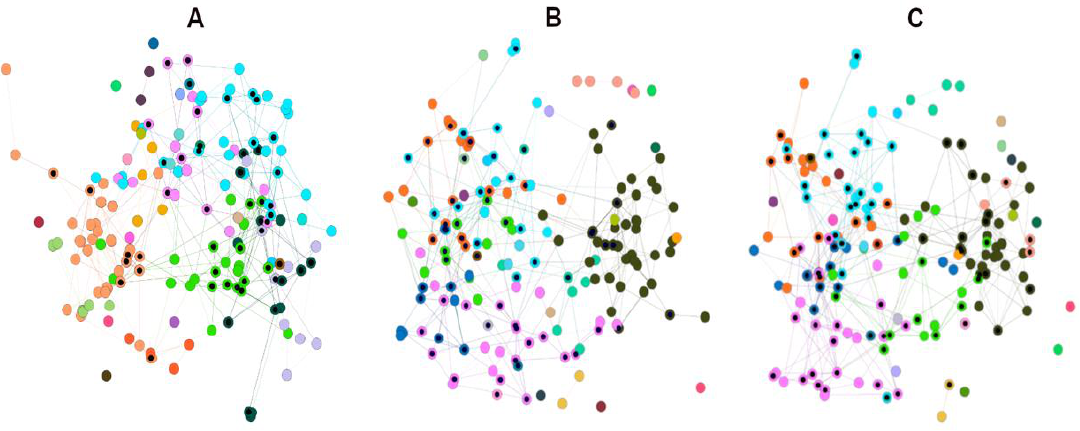
Figure 6. Overlapping subsets 6, 7 and 8 resulting from the union of the harmonic and hub-bridge centralities at 0.35, 0.40 and 0.45 over the HSPN model. ( A ) 52 ABFPs from the HC ∪ HB of the subset 8 (cutoff 0.35) over the total 174 ABFPs; ( B ) 66 ABFPs from the HC ∪ HB of the subset 7 (cutoff 0.40) over the total 174 ABFPs; ( C ) 85 ABFPs from the HC ∪ HB of the subset 6 (cutoff 0.45) over the total 174 ABFPs.